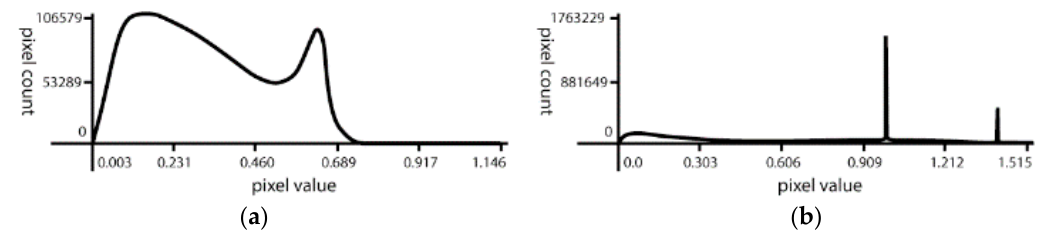
Figure 6. Feature distances ( a ); and backmatching distances ( b ) of the disparity raster.